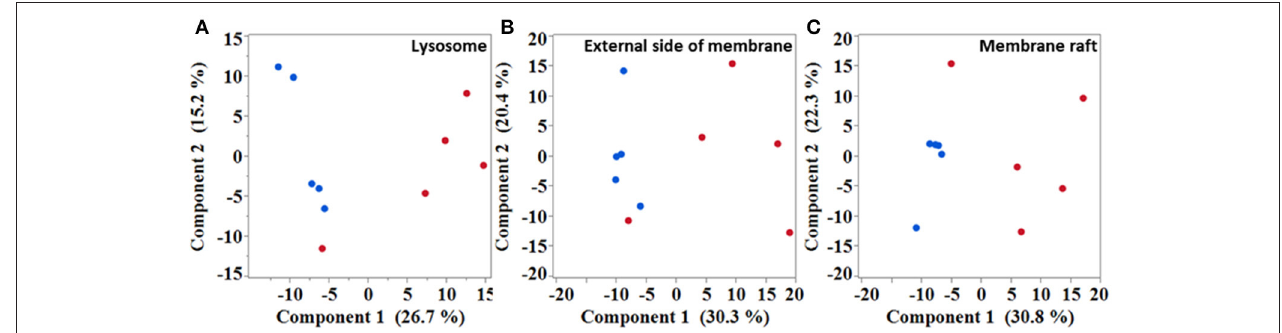
FIGURE 2 | Multivariate analysis showing samples distribution based on different subset of genes. Unsupervised principal component analysis performed with genes isolated from “lysosome” (A) , “external side of membrane” (B), and “membrane raft” (C) gene ontology terms. Blue dots, wild type; red dots, SOD1 G86R .